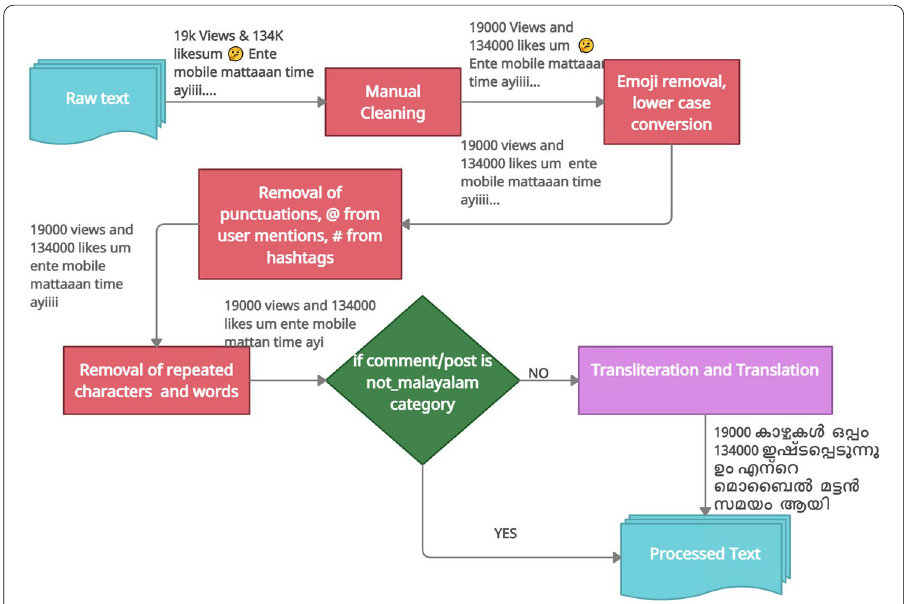
Fig. 2 Various stages of